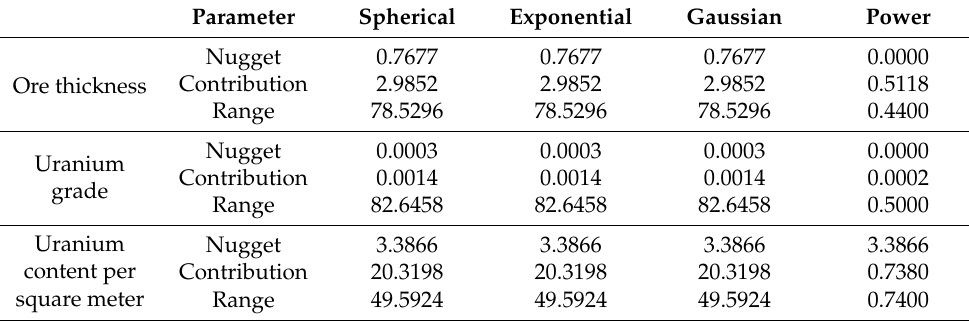
Table 2. Semivariogram parameter